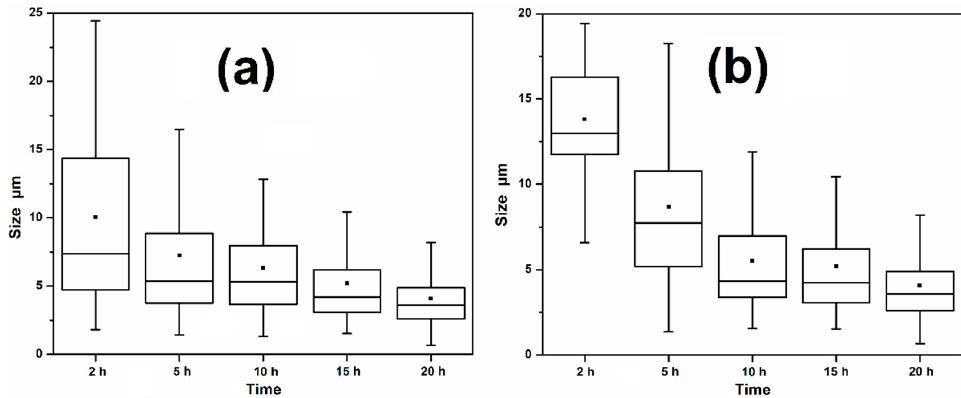
Figure 5. Particle size evolution of ( a ) Mg65–Zn30–Ca5 and ( b ) Mg70–Zn25–Ca5 when mechanically alloyed for milling times of 2, 5, 10, 15, and 20 h.